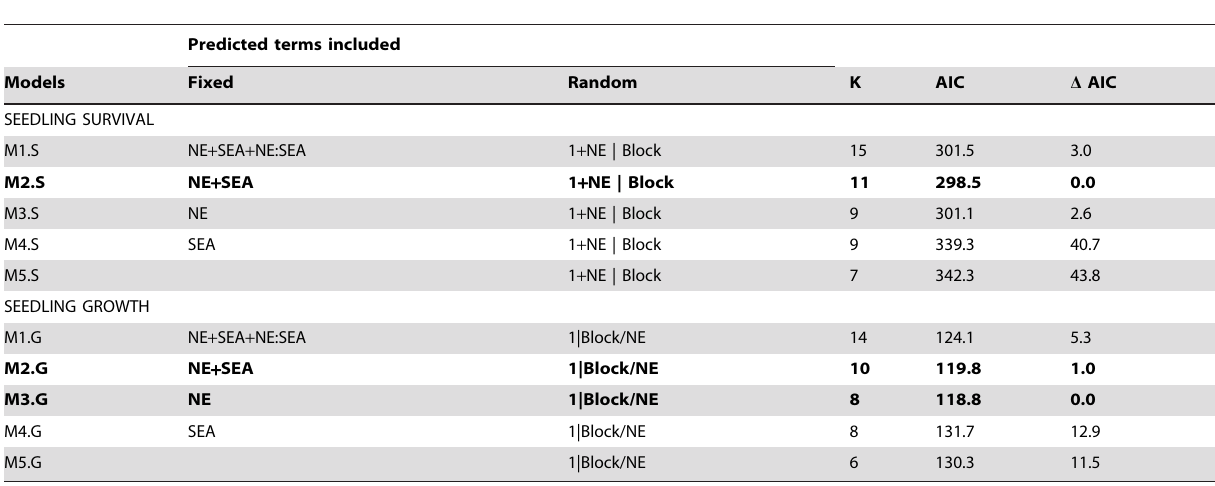
Table 1. Model selection results for the survival and growth of Ternstroemia brasiliensis seedlings.